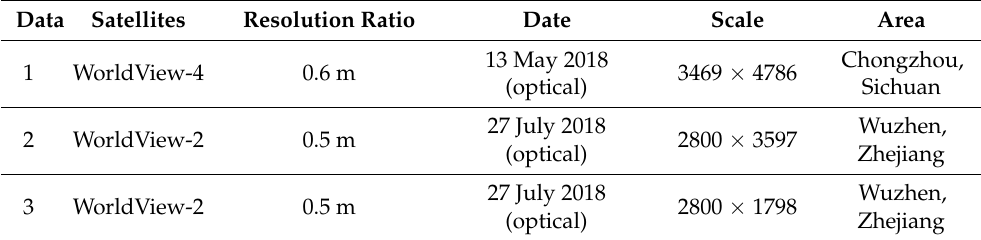
Table 1. The three source images of the self-built low-grade road